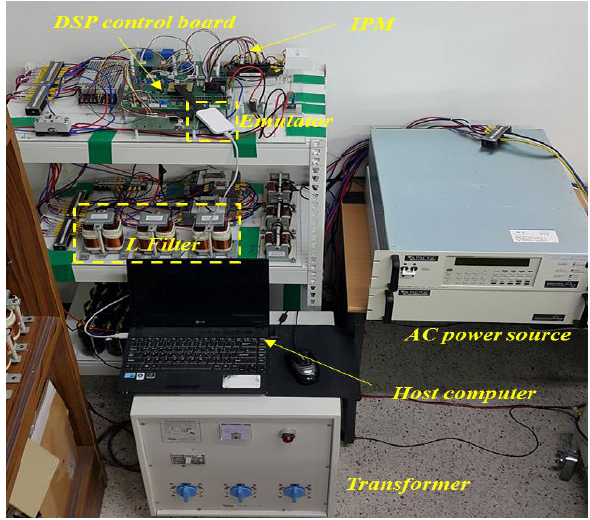
Figure 19. Experimental test setup.